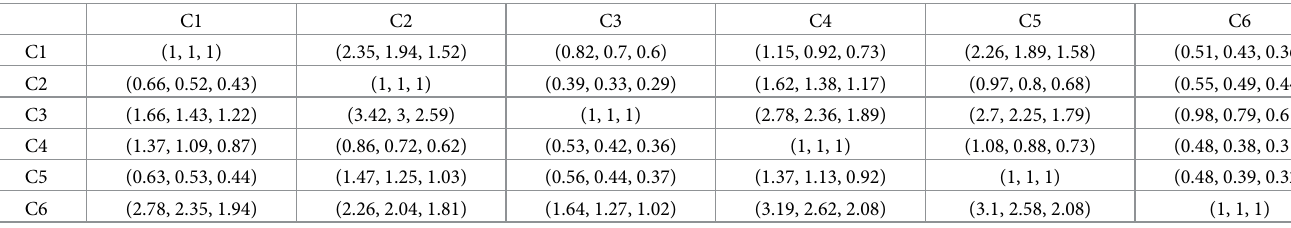
Table 10. The matrix of the paired comparison of the main